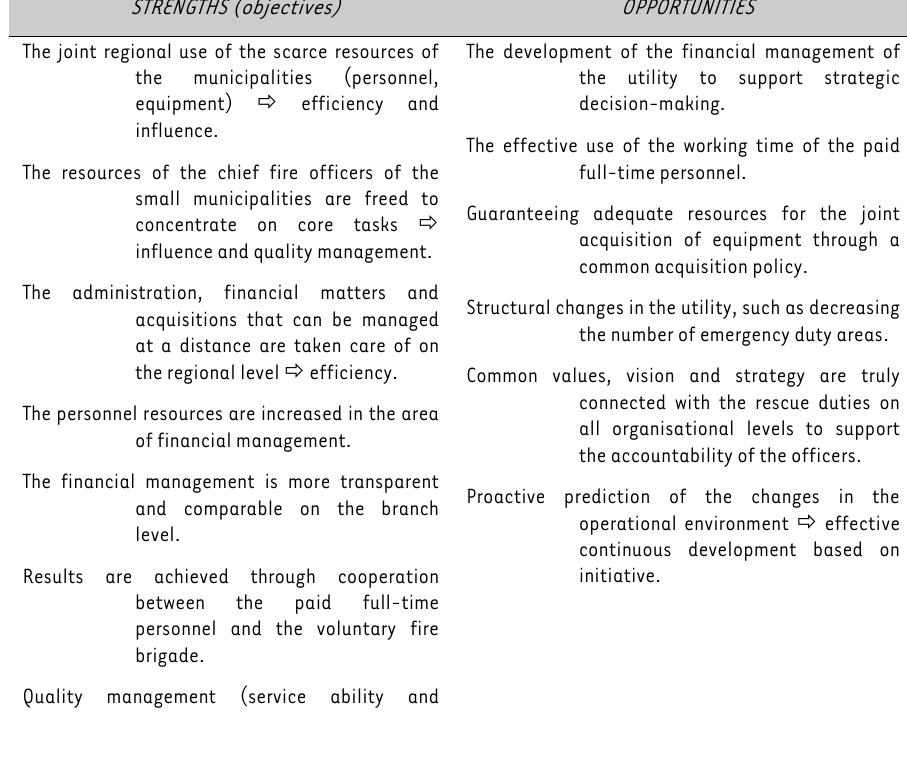
TABLE 1: SWOT analysis of the Satakunta Emergency Services from the perspective of financial